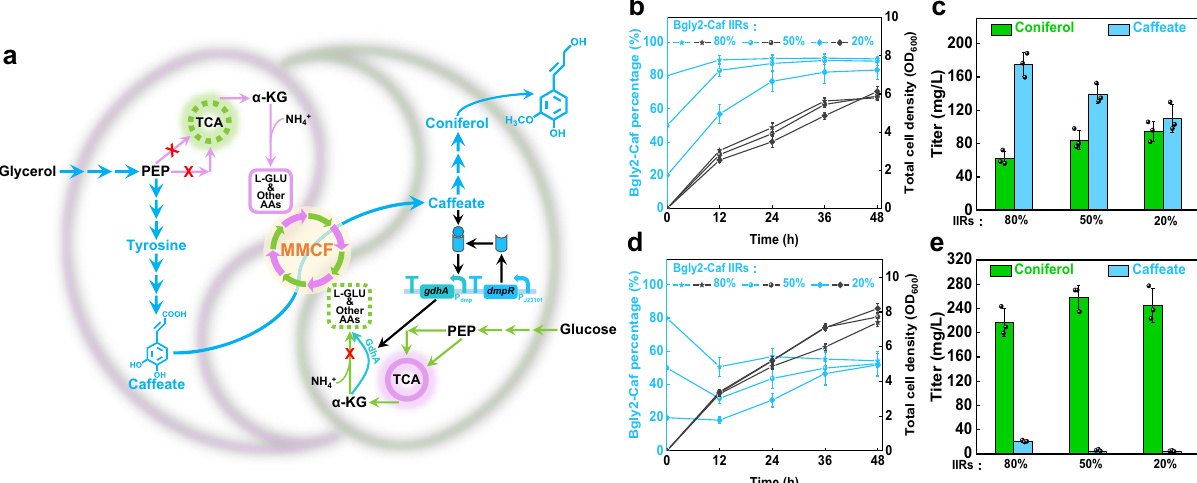
Fig. 4 Production of coniferol using coculture engineering. a Schematic of the E. coli-E. coli cocultures to accommodate the coniferol biosynthetic pathway and convert a glycerol and glucose mixture to coniferol (The coniferol biosynthetic pathway is shown in sapphire. For the detailed pathway, see Supplementary Fig. 5). b Curves of cell growth and population change in the static Bgly2-Caf/Bglc2-Con coculture. c Titers of coniferol and caffeate at 48 h in the Bgly2-Caf/Bglc2-Con coculture. d Curves of cell growth and population change in the dynamic Bgly2-Caf/Bglc2-ConDmpR coculture. e Titers of coniferol and caffeate at 48 h in the Bgly2-Caf/Bglc2-ConDmpR coculture. MMCF multi-metabolite cross-feeding, IIRs the initial inoculation ratios. Genes: gdhA encodes glutamate dehydrogenase, gltBD encodes glutamate synthase, Enzymes: GdhA glutamate dehydrogenase, DmpR the caffeate- responsive transcription factor. Metabolites: PEP phosphoenolpyruvate, α -KG α -ketoglutarate, L-GLU L-glutamate, AAs amino acids. Data shown are mean ± SD ( n = 3 independent experiments). Source data are provided as a Source Data fi